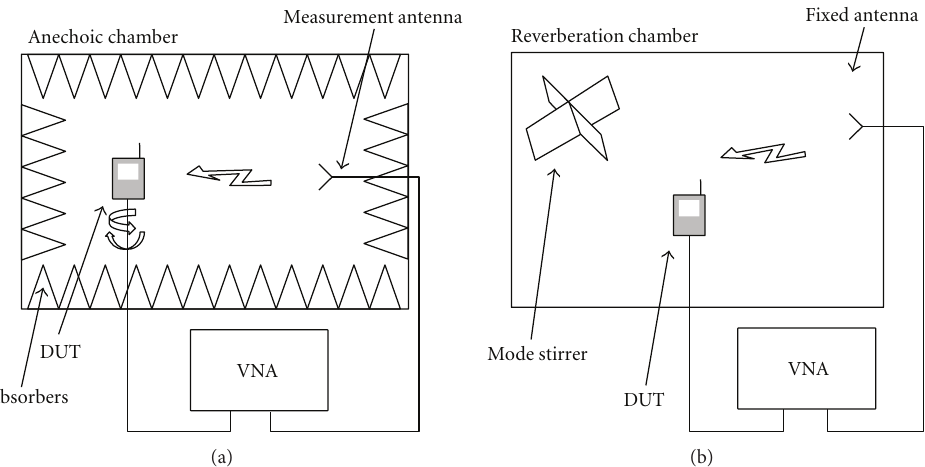
F 8: Example measurement setups for passive (cable-fed) testing of antennas for wireless handheld devices. For active device testing the DUT is replaced by a functional handset, and the vector network analyzer (VNA) is replaced by a base station simulator.